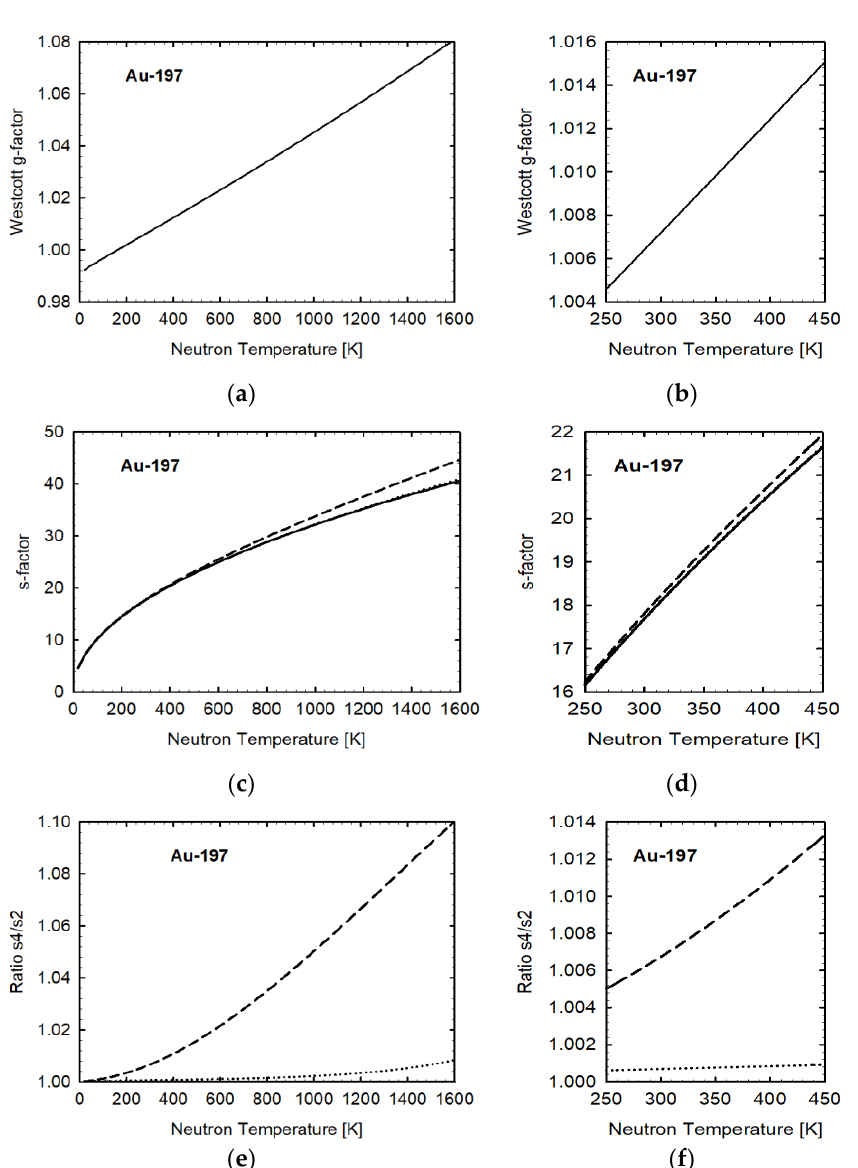
Figure 8. ( a ) Westcott g-factor for 197 Au as a function of neutron temperature T n ; ( b ) Expanded figure of ( a ); ( c ) s-factors, s 2𝑊 (solid line), s 4𝑊 (dotted line), s 4𝐻 (dashed line) for 197 Au as a function of neutron temperature 𝑇 𝑛 ; ( d ) Expanded figure of ( c ); ( e ) Ratios of s-factor s 4𝑊 /s 2𝑊 (dotted line) and s 4𝐻 /s 2𝑊 (dashed line) for 197 Au; ( f ) Expanded figure of ( e ).